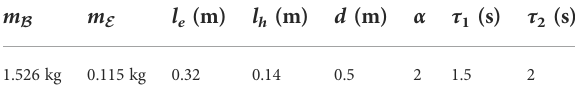
TABLE 1 Key parameters of the developed SoAG robot.